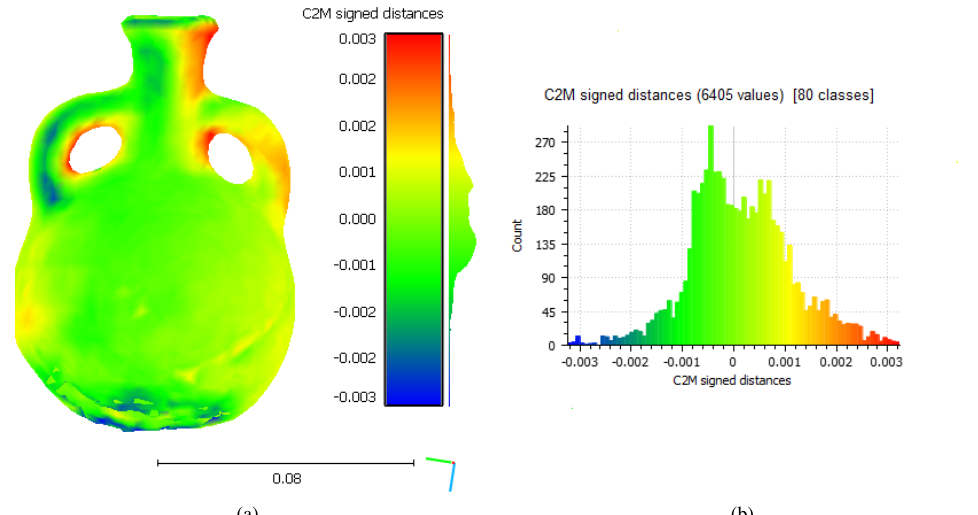
Figure 4: (a) Distances between the points of the Structure Sensor model and the mesh of the medium resolution photogrammetric model; (b) related histogram.